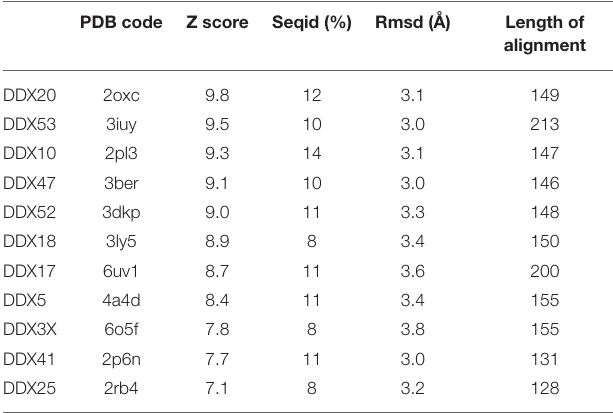
TABLE 2 | Structural similarity of SARS-CoV-2 Nsp13 with human DDX helicases, as computed by DALI. PDB code Z score Seqid (%) Rmsd (Å) Length of